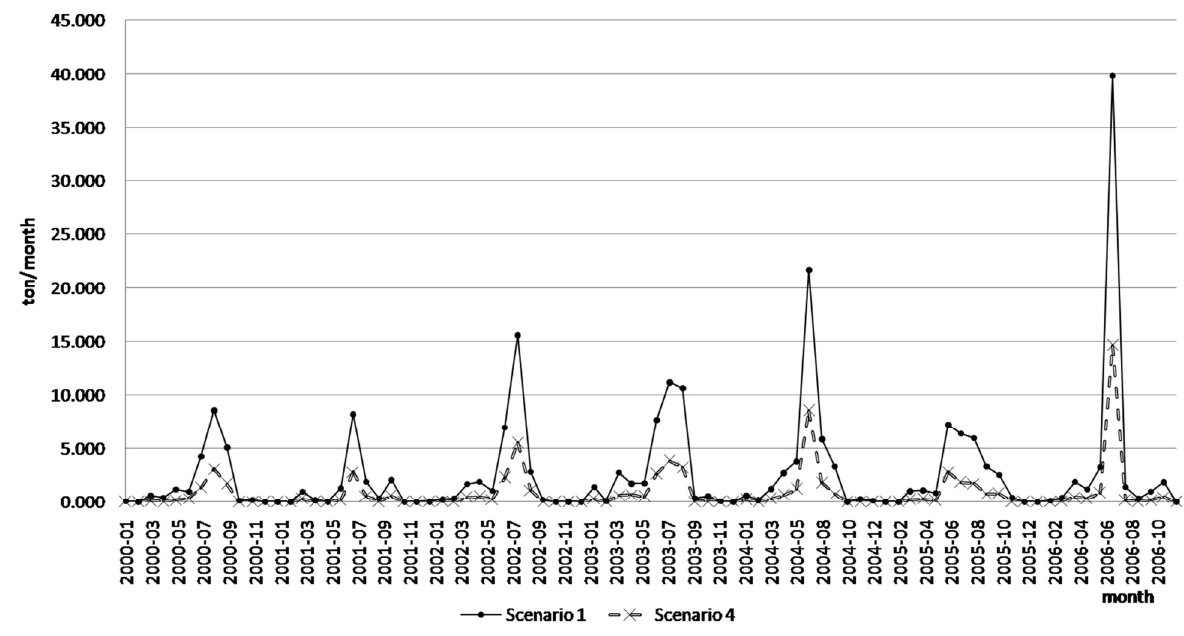
Figure 18. Comparison of Simulated Monthly Sediment for Scenarios 1 and